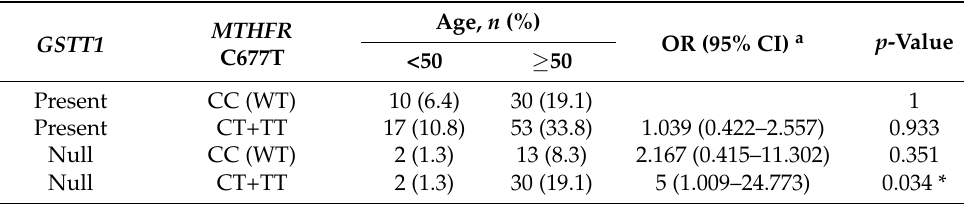
Table 6. Association between GSTT1 and MTHFR C677T genotypes combination and patient age at diagnosis of breast